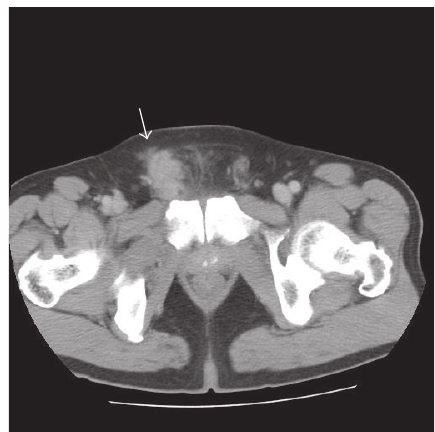
Figure 2: Abdominal CT. Abdominal CT reveals a 3.7 cm diameter slightly enhanced tumor (arrrow) in the right spermatic cord.